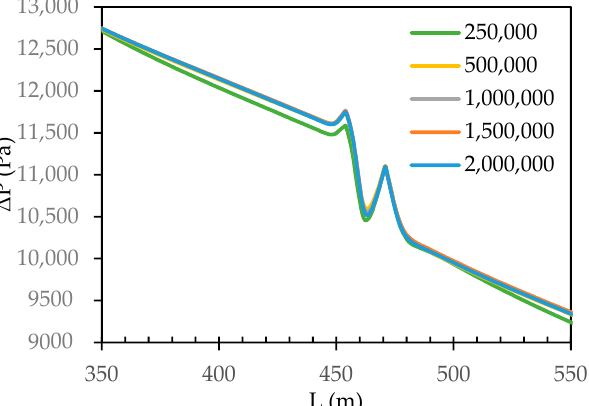
Figure 6. Development of the transmembrane pressure profile along the centreline in the flow path for the five grid cell counts.